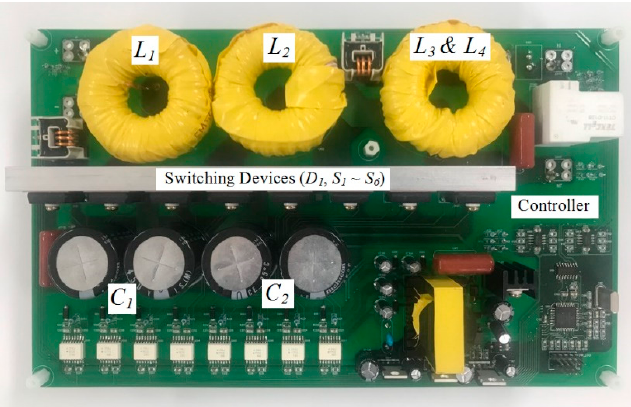
Figure 7. Picture of the prototype inverter.